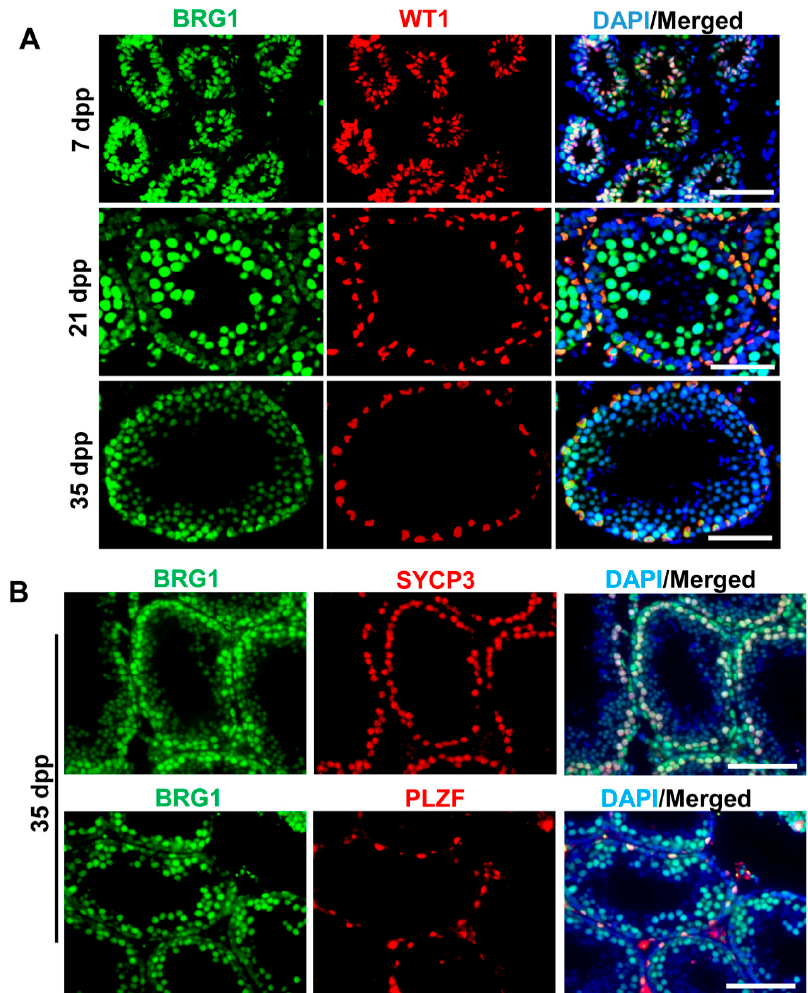
Figure 1. BRG1 protein is highly expressed in both Sertoli cells and germ cells. (A ) Co-localization of BRG1 and WT1 was examined by IHF in testes from mice at various ages. Scale bars: 100 μ m. ( B ) Co- localization of BRG1 and germ cell specific proteins PLZF and SYCP3 was examined by IHF in testes from mice at 35 dpp. Scale bars: 100 μ m. testes from mice at 35 dpp. Scale bars: 100 µ